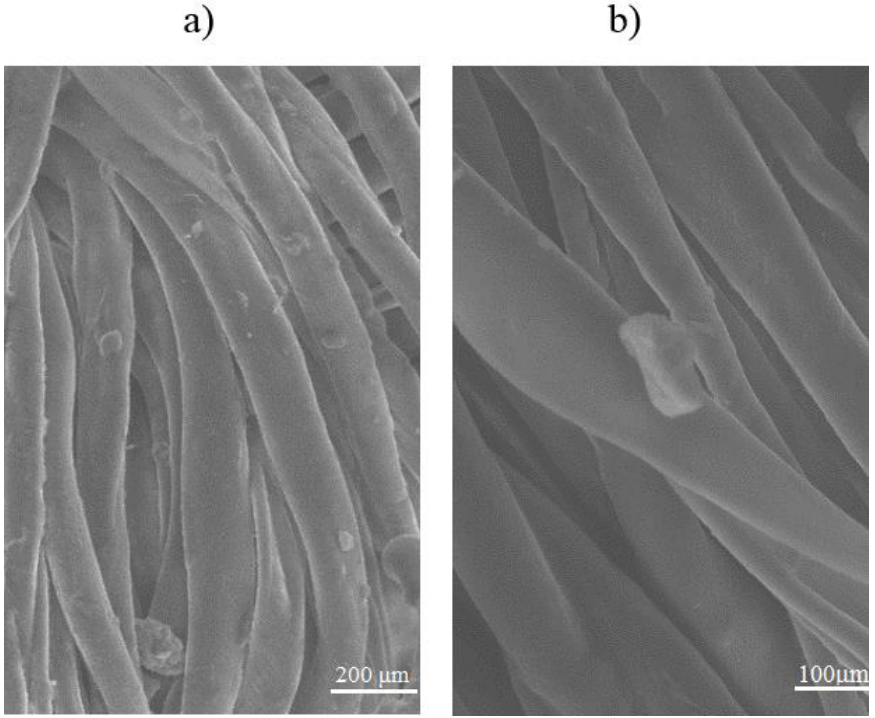
Figure 3. SEM images of treated fabric: ( a ) under × 200 magnification and ( b ) under × 400 magnification.